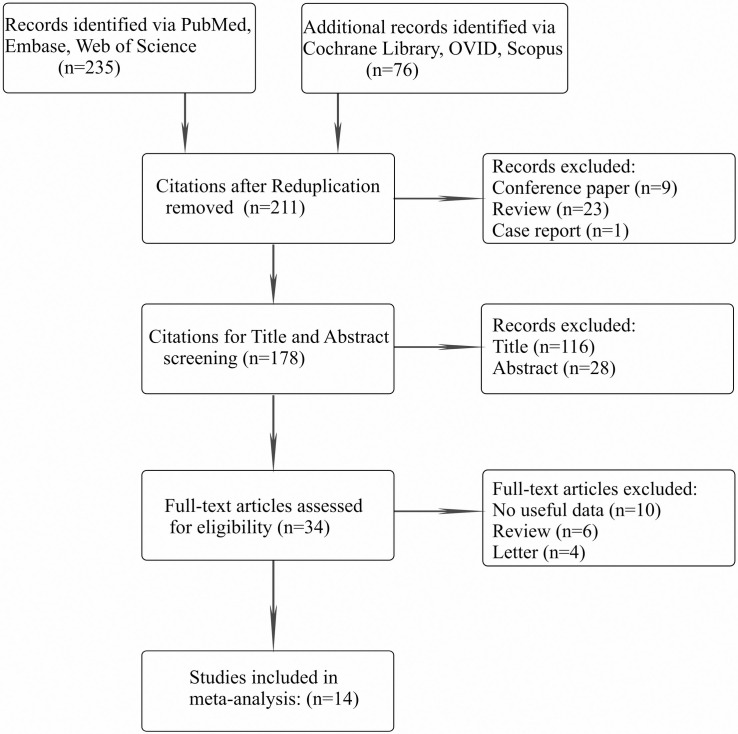
The PRISMA flow diagram of the inclusion process.